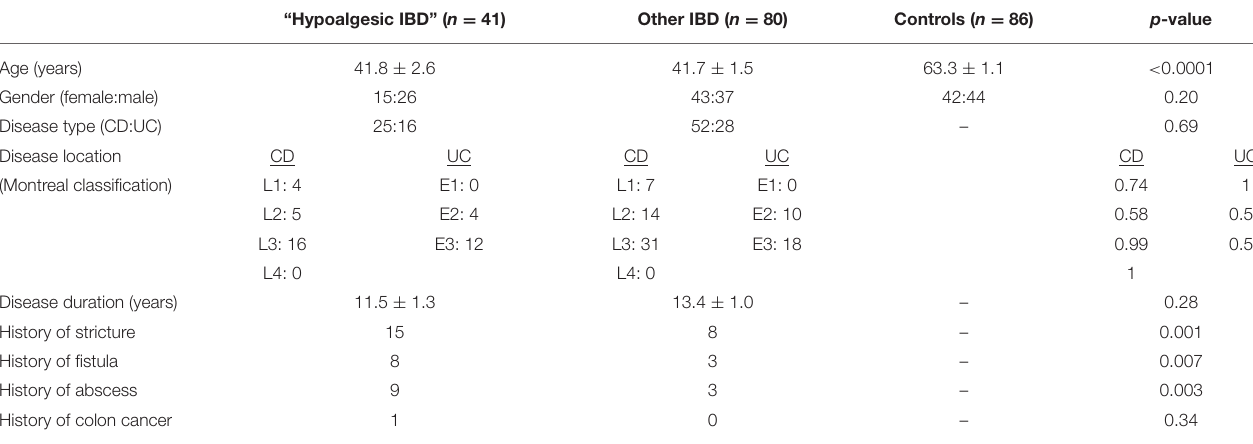
TABLE 1 | Study participant demographic and disease